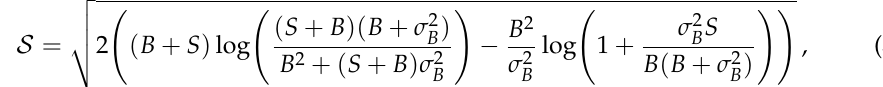
Figure 5. Distributions of the transverse mass of the second lepton m 2 mass m eff ( right ), for signal and background after requiring two b -jets, two OS leptons and satisfying Equations